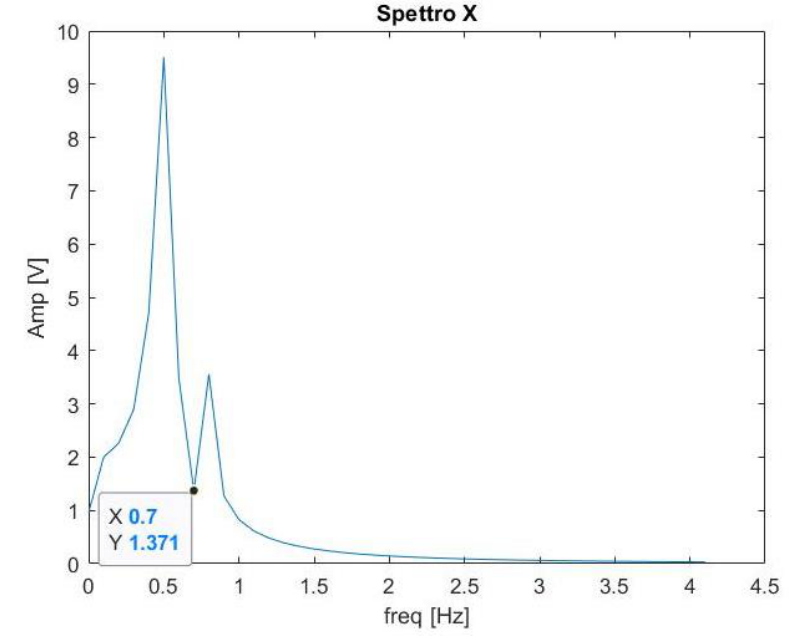
Figure 2. Spectrum of the signal y ( t ) of Equation (17).